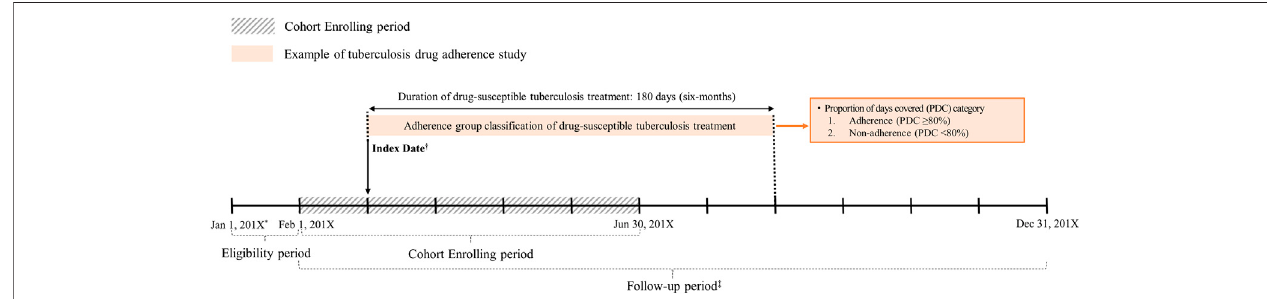
FIGURE1| Studydesignofdrug-susceptibletuberculosisadherencestudy.*201X:2017or2018. † The fi rstdateofprescriptionwithaquadrupleortripleregimen. ‡ Prescribed at least one of fi rst-line tuberculosis drugs; fi rst-line drugs for drug-susceptible tuberculosis: isoniazid, rifampicin (rifampin), rifabutin, ethambutol,